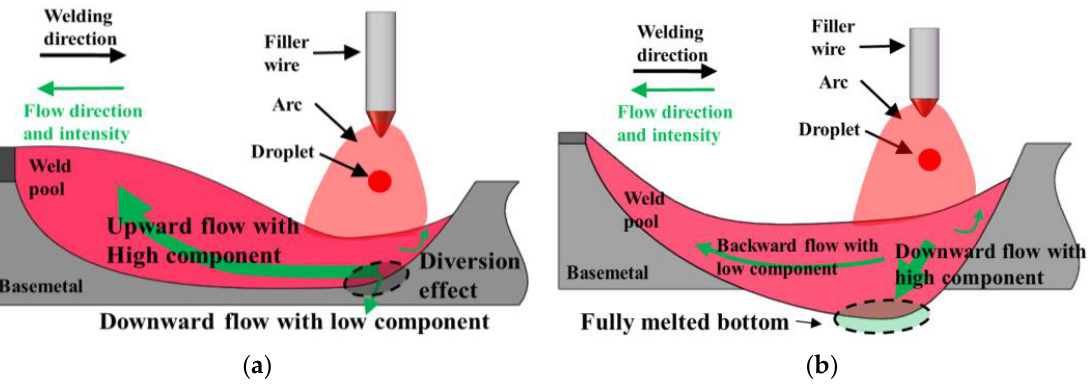
Figure 4. Schematic diagram of fluid flow in weld pool with ( a ) solid bottom wall and ( b ) molten bottom wall.